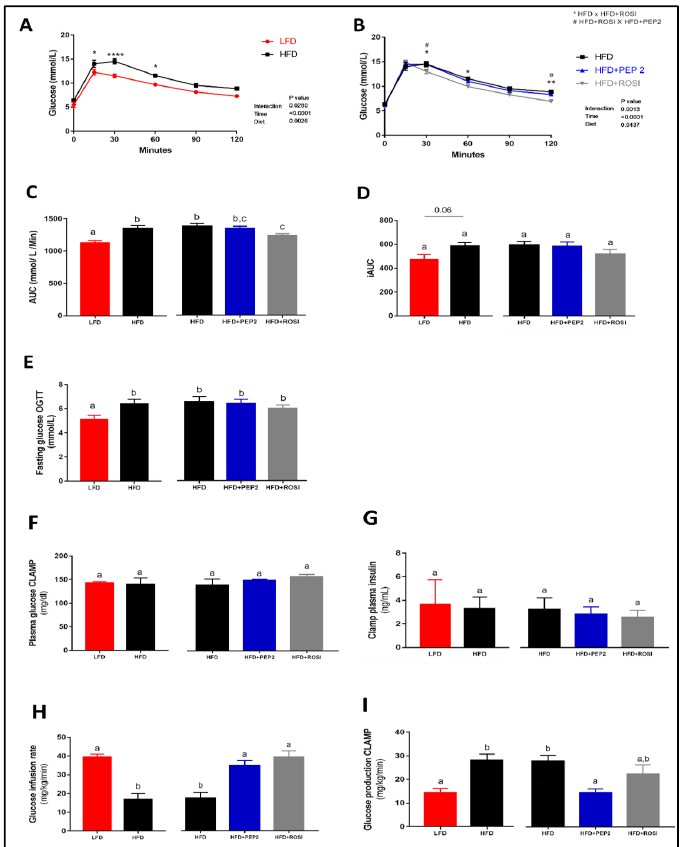
Figure 2. Glucose tolerance test and hyperinsulinemic-euglycemic clamp in mice treated with Pep- tide 2 (Protocol 2). ( A , B ) Glucose tolerance test (OGTT), ( C ) OGTT area under the curve (AUC), ( D ) OGTT incremental AUC, ( E ) overnight fasting glucose on OGTT day (n = 11–12). Data expressed as mean ± SEM and analyzed by two-tailed t-test (LFD vs. HFD) and by one-way ANOVA or Kruskal- Wallis (HFD groups) or two-way ANOVA. In the hyperinsulinemic-euglycemic clamp: ( F ) plasma glucose concentration; ( G ) plasma insulin; ( H ) glucose infusion rate and ( I ) glucose production. Data expressed as mean ± SEM of n = 4–7 and analyzed by two-tailed t-test (LFD vs. HFD) or by one-way ANOVA (HFD groups). Bars with different letters indicate p < 0.05. * and # indicate p < 0.05; ** indicates p < 0.01; **** indicates p < 0.0001.